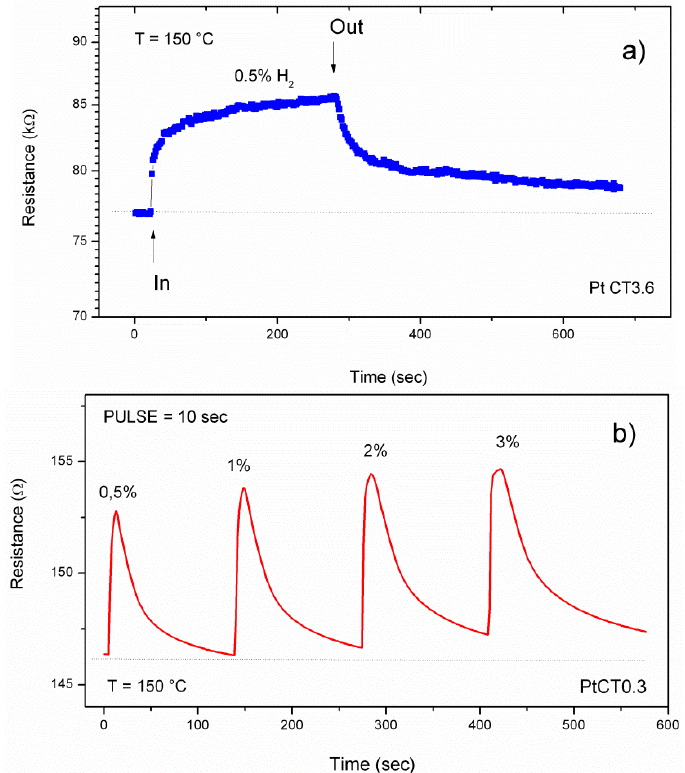
Figure 7. Resistance change at 150 °C of sensors to hydrogen pulses. ( a ) PtCT3.6; ( b ) PtCT0.3 to hydrogen pulses of the duration of 10